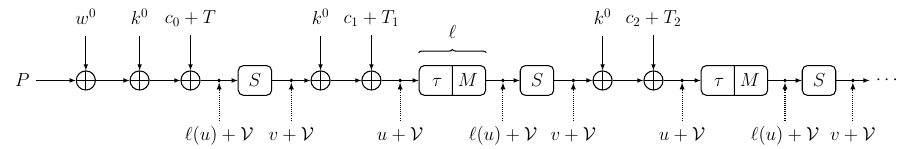
Figure 9: Propagation of Invariant Subspace Cosets in the Forward Rounds